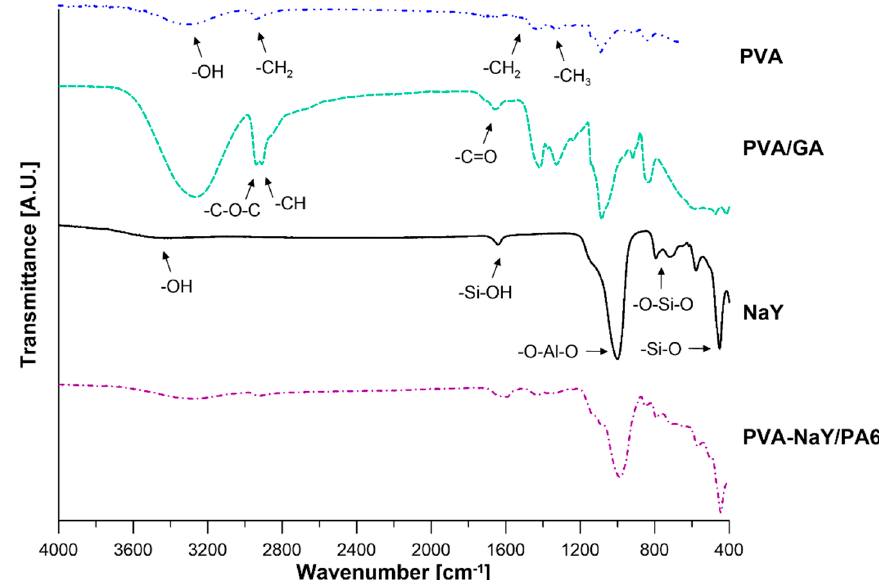
Figure 6. FTIR spectra of PVA pristine membrane, PVA membrane crosslinked with glutaraldehyde (PVA/GA), zeolite (NaY) filler, and the composite membrane (PVA-NaY/PA6).